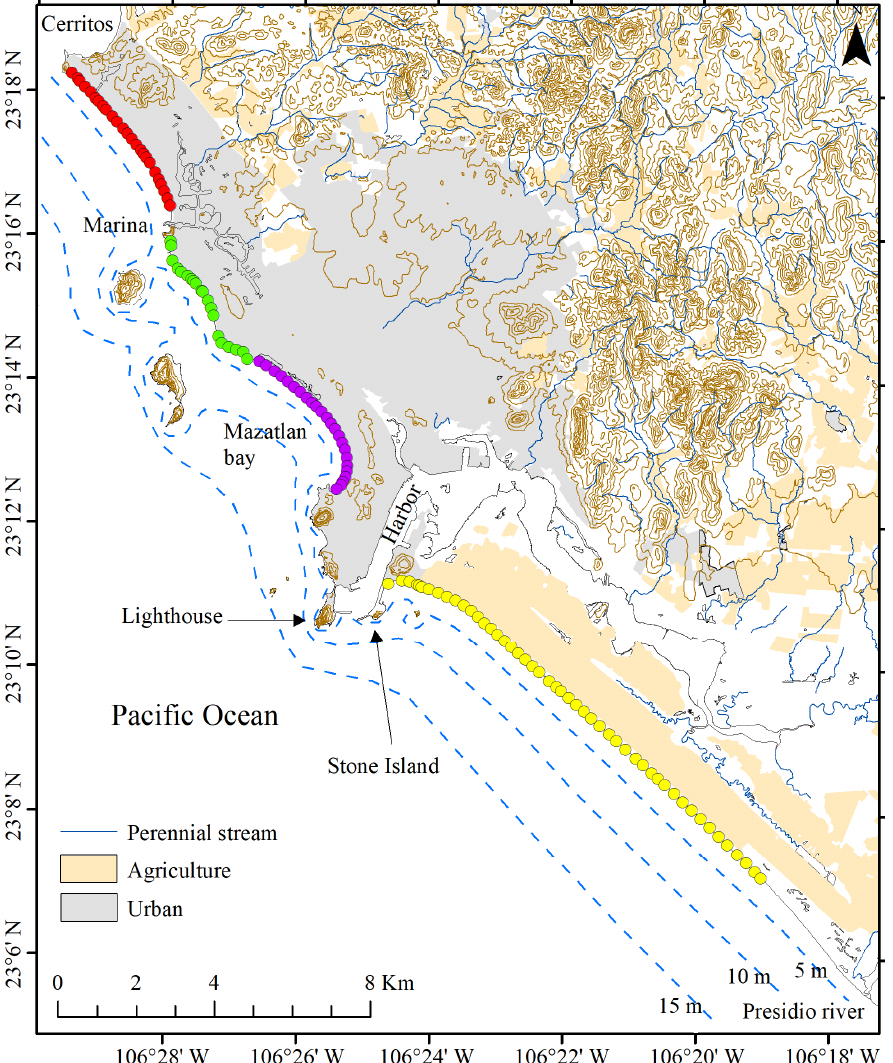
Figure 1. Location of the touristic port of the Mazatlan coastline, Pacific coast of Mexico. The small colored circles indicate the location of the on-site transects: Northern point with non-continuous buildings (red), continuous resorts with no direct access to the beach (green), concrete oceanfront corridor with no constructions in front of the beach (purple), and conserved area without coastal infrastructure (yellow). The brown contour lines indicate the elevation intervals at every 50 m. The dashed lines indicate the bathymetry at depths of 5, 10, and 15 m.